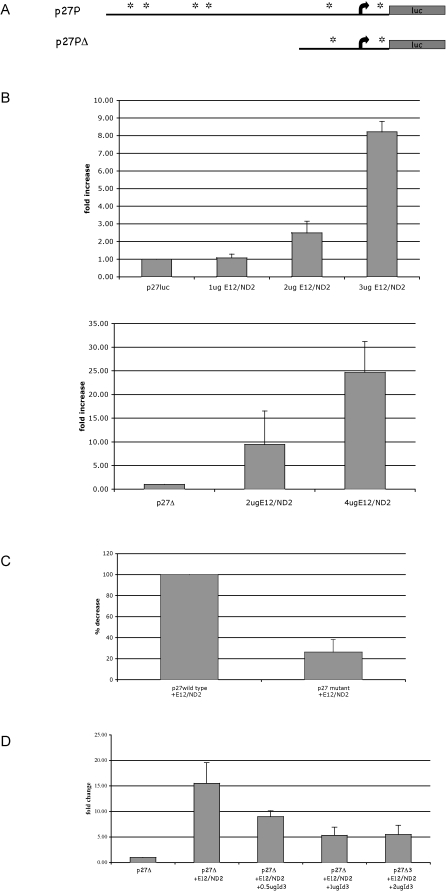
Id3 Regulates Expression of p27 Promoter Reporter Construct(A) A schematic of the full-length p27 promoter and a minimal p27 promoter are shown. The E-box sequences CANNTG are marked by asterisks.(B) The E12/NeuroD2 E-protein heterodimers activate the full-length and minimal p27 promoters.(C) The percent induction of the mutant p27 minimal promoter, with three of the four conserved bases in the E boxes mutated (CANNTG to CGNNAT), is shown relative to the wild-type promoter.(D) Id3 represses E-protein activation of the p27 minimal promoter. The SV40-β-galactosidase or CMV-β-galactosidase plasmids were used as an internal control for each sample.doi:10.1371/journal.pgen.0030219.g003